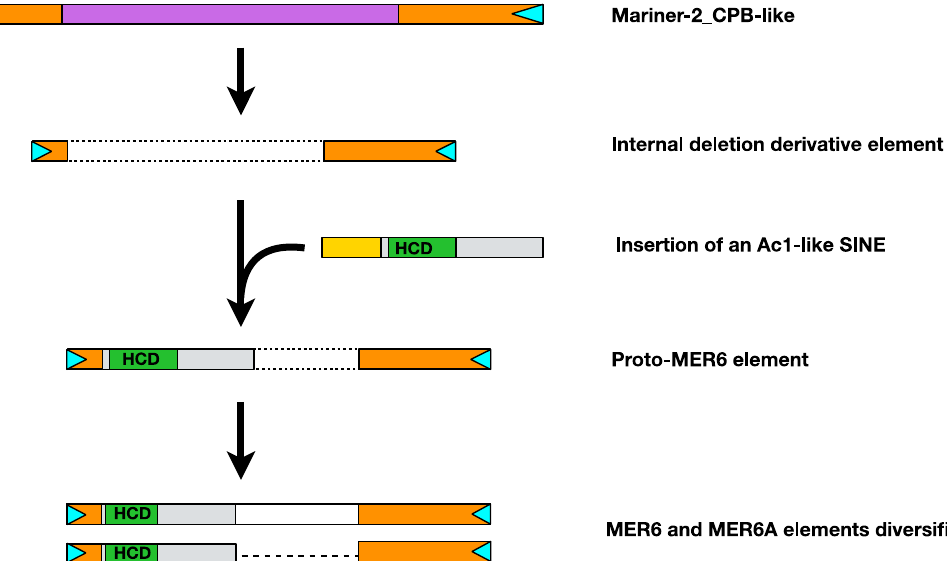
Figure 6. Stepwise origin of MER6 elements. The original Tc1 / Mariner element, homologous to Mariner-2_CPB, lost the internal domain containing the transposase coding sequence (purple box) producing an internal deletion derivative MITE element. Then, an Ac1-like short interspersed element (SINE) inserted in the MITE (HCD: V highly conserved domain). The new composite MITE, then, diversified into MER6 and MER6A elements.